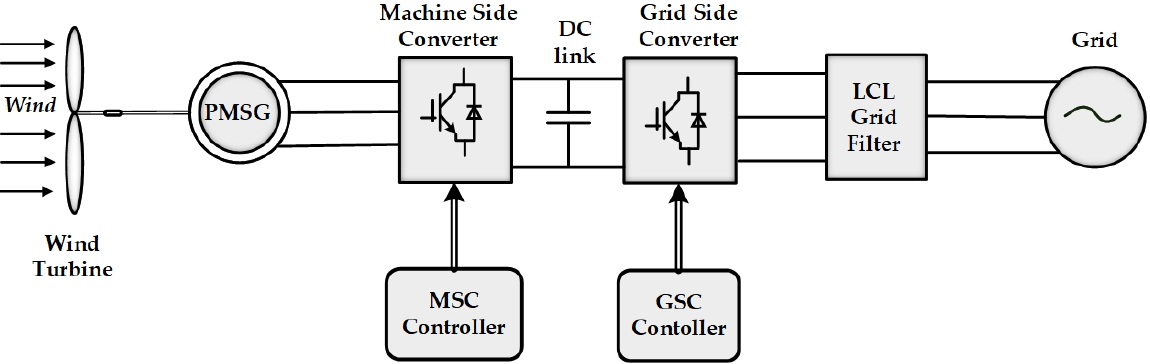
Figure 1. Configuration of a gearless PMSG-based WECS connected to a grid through a BTB power converter.